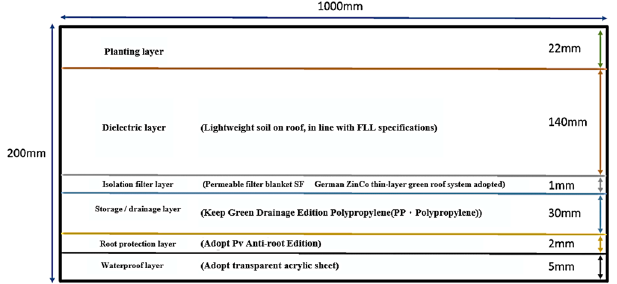
Figure 4. Schematic of a thin green roof.